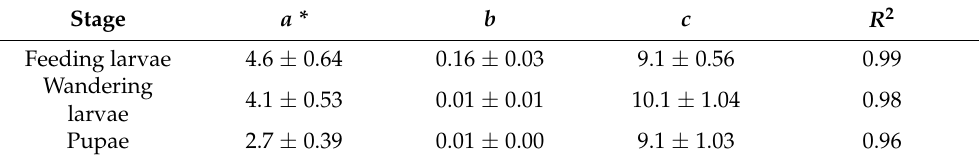
Table 4. Parameter estimates ( ± SE) of survival model (Eq. 1) of immature stages of SHB.